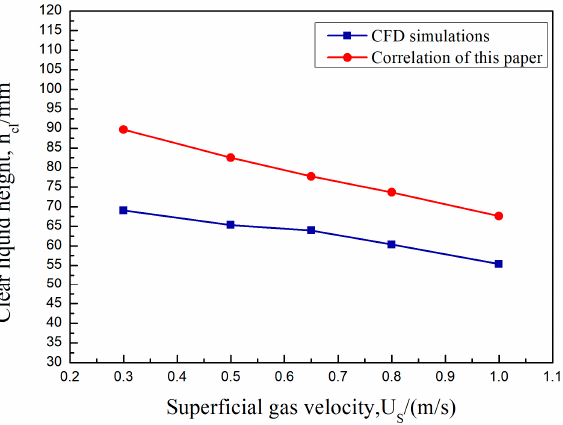
Figure 5. Clear liquid height as a function of the superficial gas velocity. h W = 0.054 m, Q L / L w = 20 m 3 /(m·h).